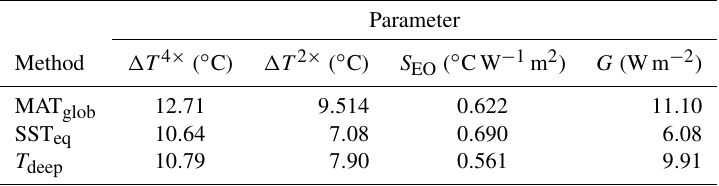
Table 5. Temperature differences comparing the 38Ma 4 × PIC ( (cid:49)T 4 × ) and 2 × PIC ( (cid:49)T 2 × ) Eocene climate to the pre-industrial reference as well as derived values for equilibrium climate sensitivity ( S ) and forcing from (integral) geography changes ( G ) using Eq. (2). Results are shown using global average 2m temperature, equatorial SST (with a 3 / 2 ratio, as discussed in Royer et al., 2012), and deep-sea temperature (below